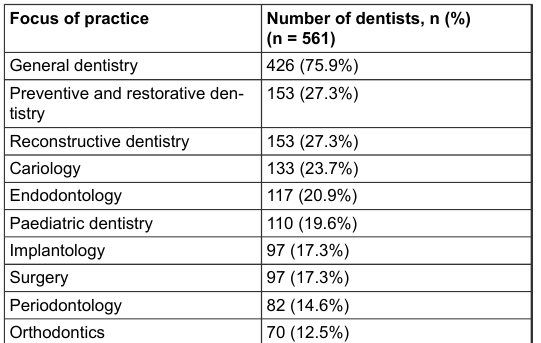
Table 2: Focus of practice of the participating dentists with several answers possible, with the number (and percentage) of dentists working in the respective field of